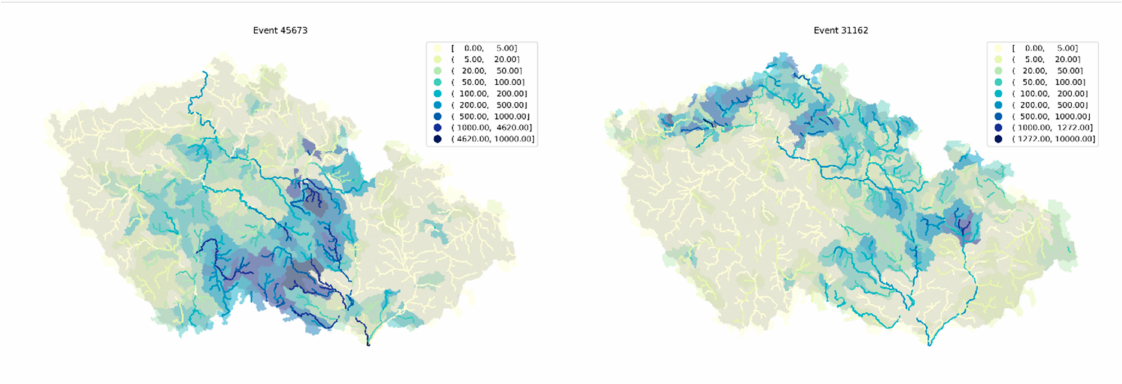
Figure 8. Example of the 41st largest market events: reference period, right—RCP 8.5 2075–2100 scenario without adaptation and expressed in the return period valid for reference period (lines— Figure 9). Relative comparison of the sum of the top losses on the market portfolio per climate scenario without adaptation, in comparison with the reference period: left —GU loss, right —Gross loss.